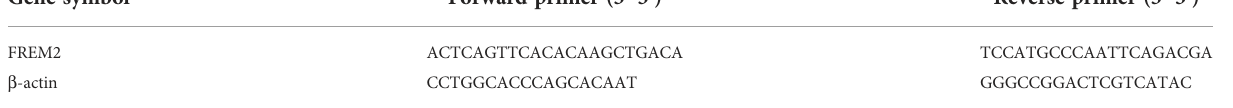
TABLE 1 Primers designed for